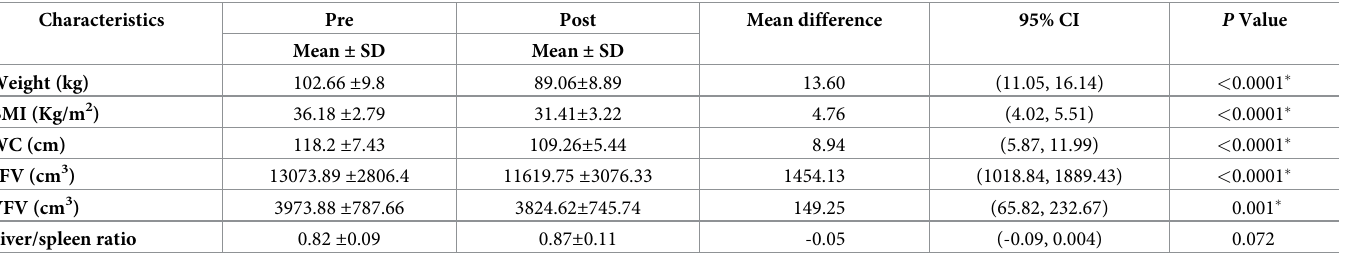
Table 4. Weight, body mass index, waist circumference, subcutaneous fat volume, visceral fat volume, and Liver/spleen ratio pre- and post-intervention for control group.